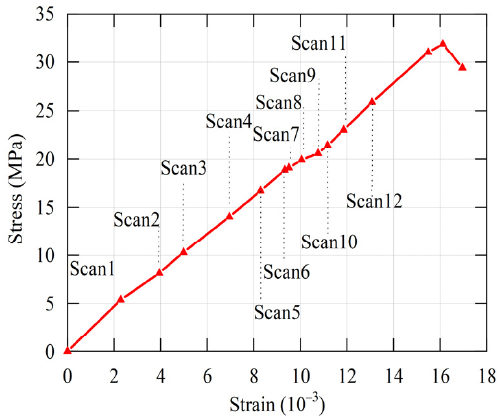
Figure 2. CT-scan and stress–strain-relationship diagram.